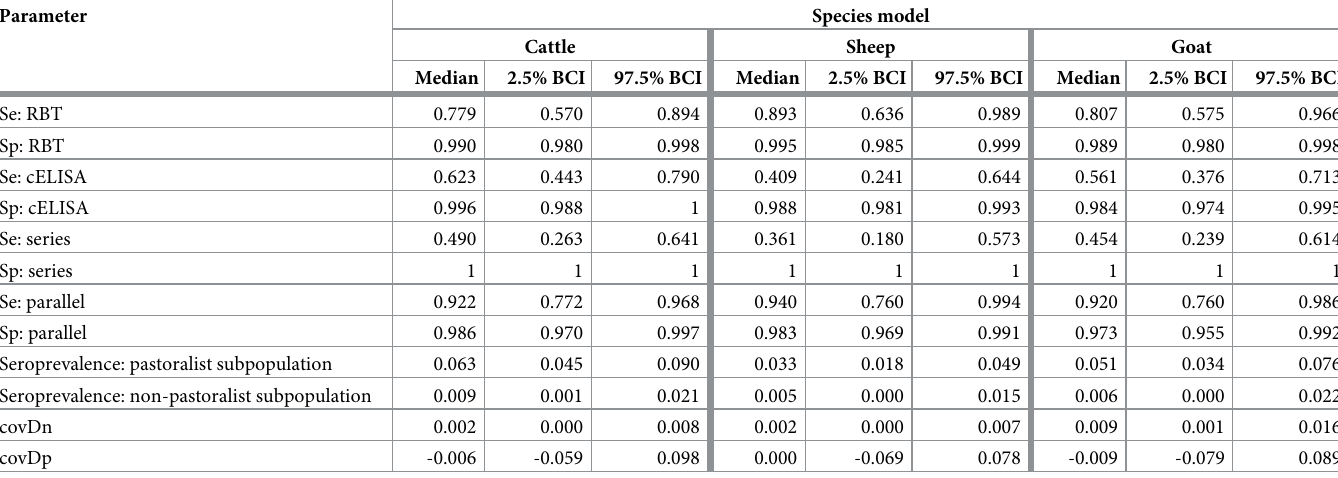
The RBT and cELISA median posterior estimates for specificity were consistently high across species models, whereas median posterior estimates for sensitivity were more variable between tests and across cattle, sheep, and goat models. Brucella spp. seroprevalence for all livestock species was estimated to be higher in the pastoralist subpopulation than the non-pastoralist population. The parallel RBT and cELISA testing approach gave the overall best diagnostic test performance estimates across all species models, as compared to series testing. To our knowl- edge, this is the first study using Bayesian latent class analysis to compare RBT and cELISA test performance to identify Brucella spp. exposure in cattle in Tanzania, and the first for sheep and goats in Africa. There was considerable variation in the median posterior estimates for sensitivity for both diagnostic tests across the different species models. Median posterior estimates for sensitivity were less precise than specificity with wider credibility intervals. The widest BCI was for Table 4. Median posterior and 95% Bayesian credibility interval parameter estimates for cattle, sheep, and goat models.